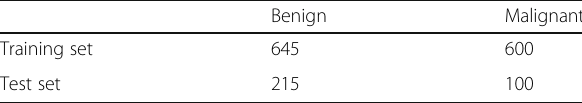
Table 2 Augmented dataset and its division into training and test